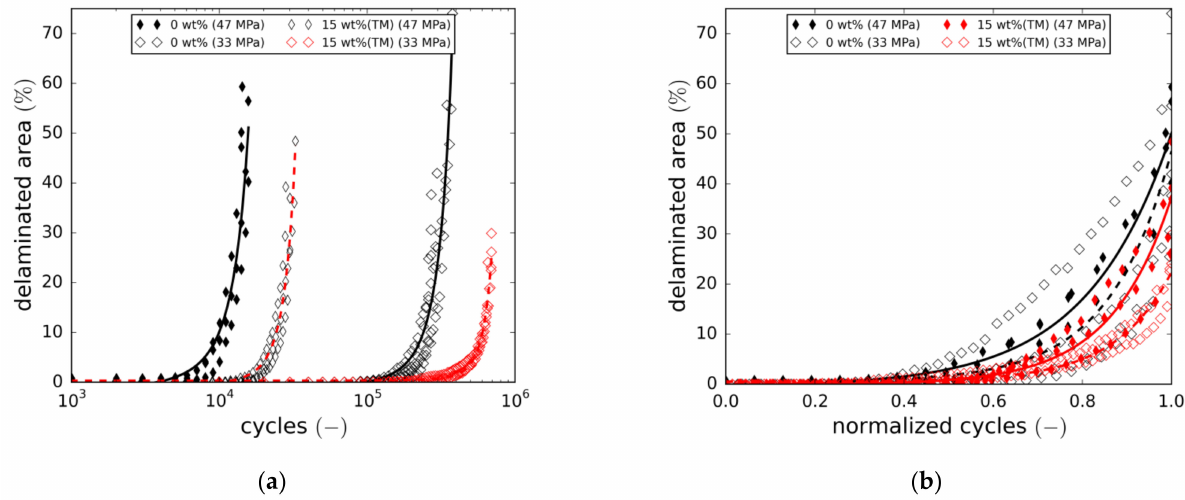
Figure 13. ( a ) Delaminated area fraction vs. number of normalised cycles; ( b ) Correlation of crack density and